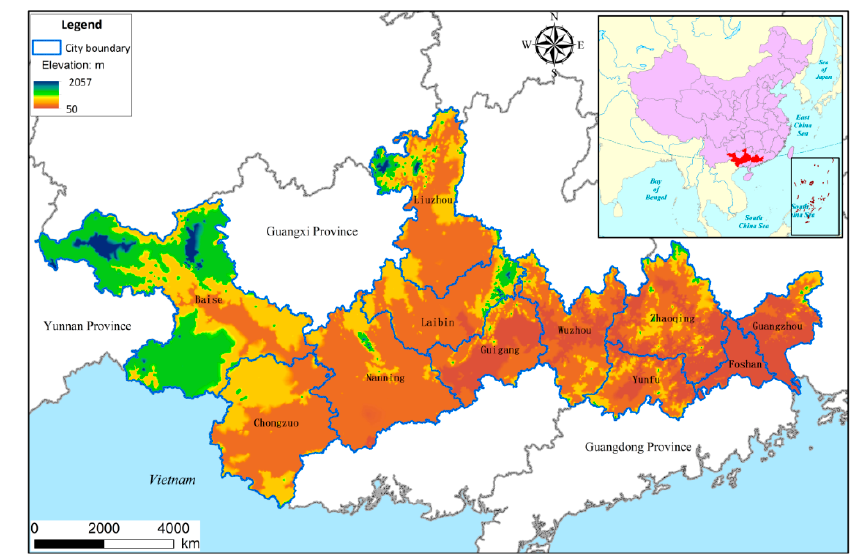
Figure 1. Location of the study area and its eleven municipalities.